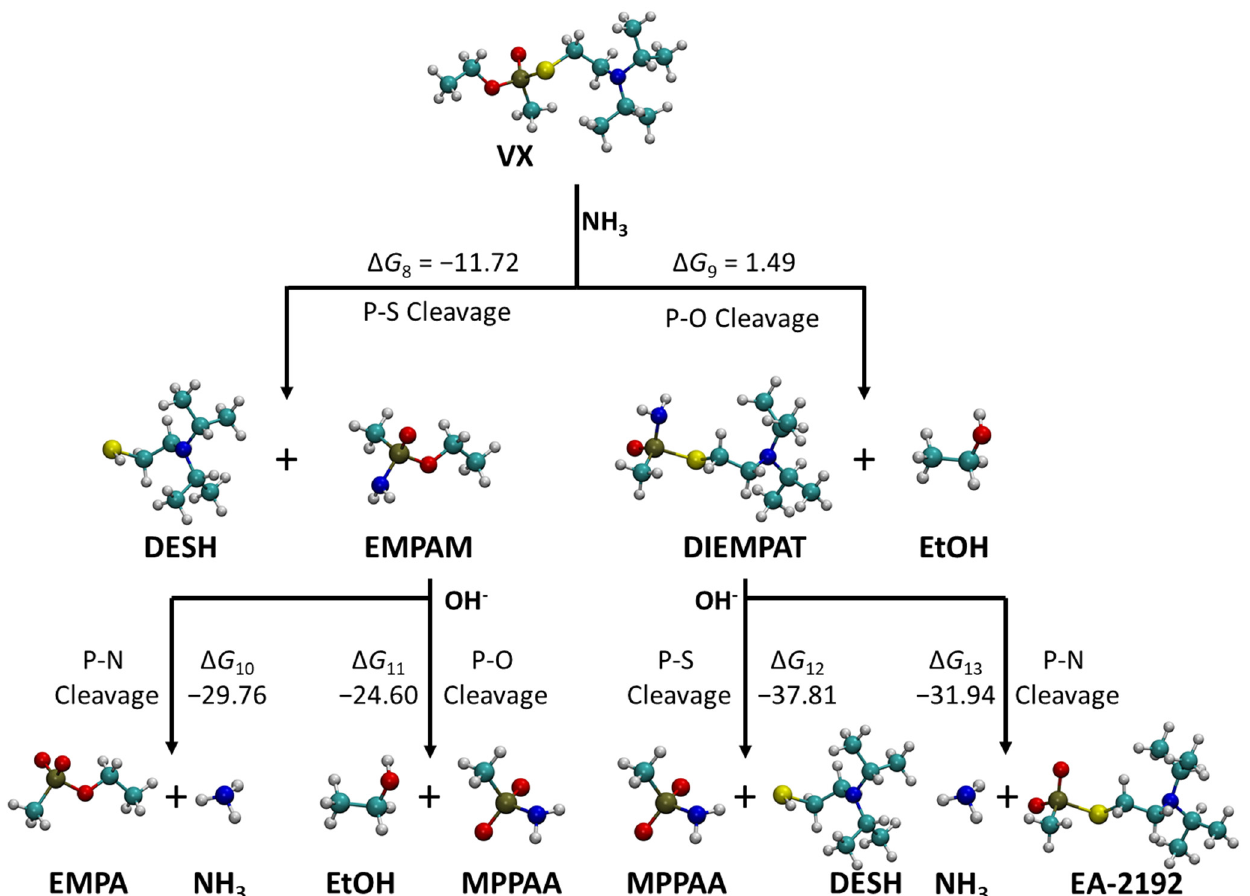
Figure 4. Full aqueous neutralization pathway for VX starting with an initial ammonolysis Table 3. Reaction free energy comparison for various computational methods for the reaction path- ways 8–13 in Figure 4.